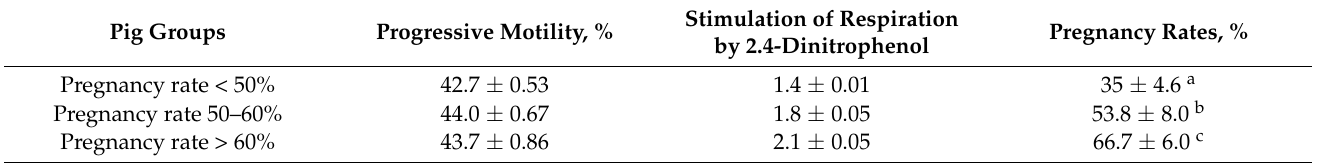
Table 2. Pregnancy rates of boar semen with different stimulation rates by 2.4-dinitrophenol.